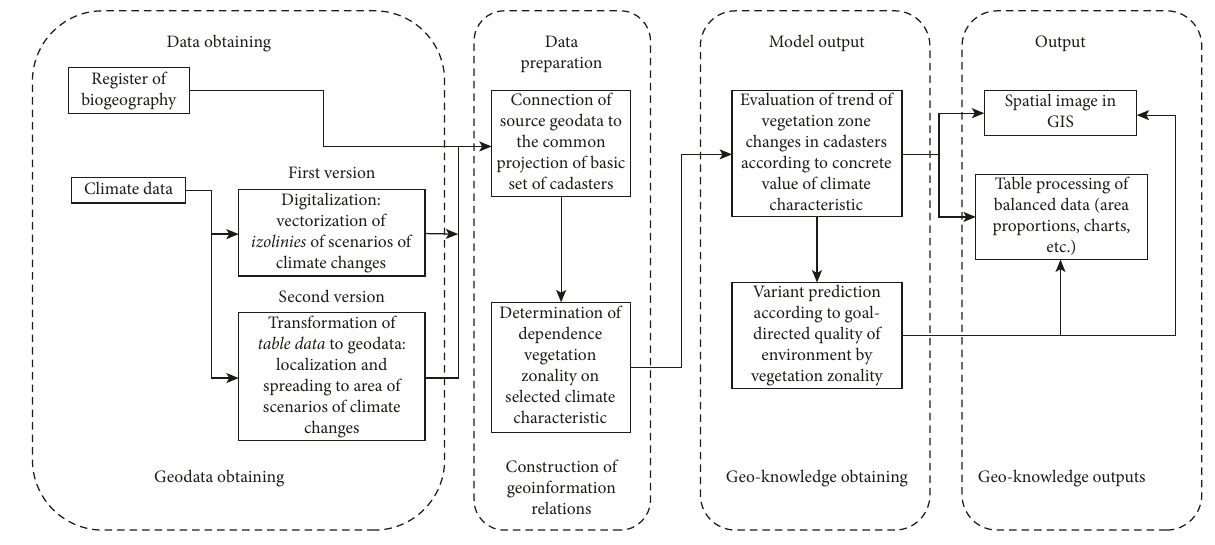
Table processing of balanced data (area